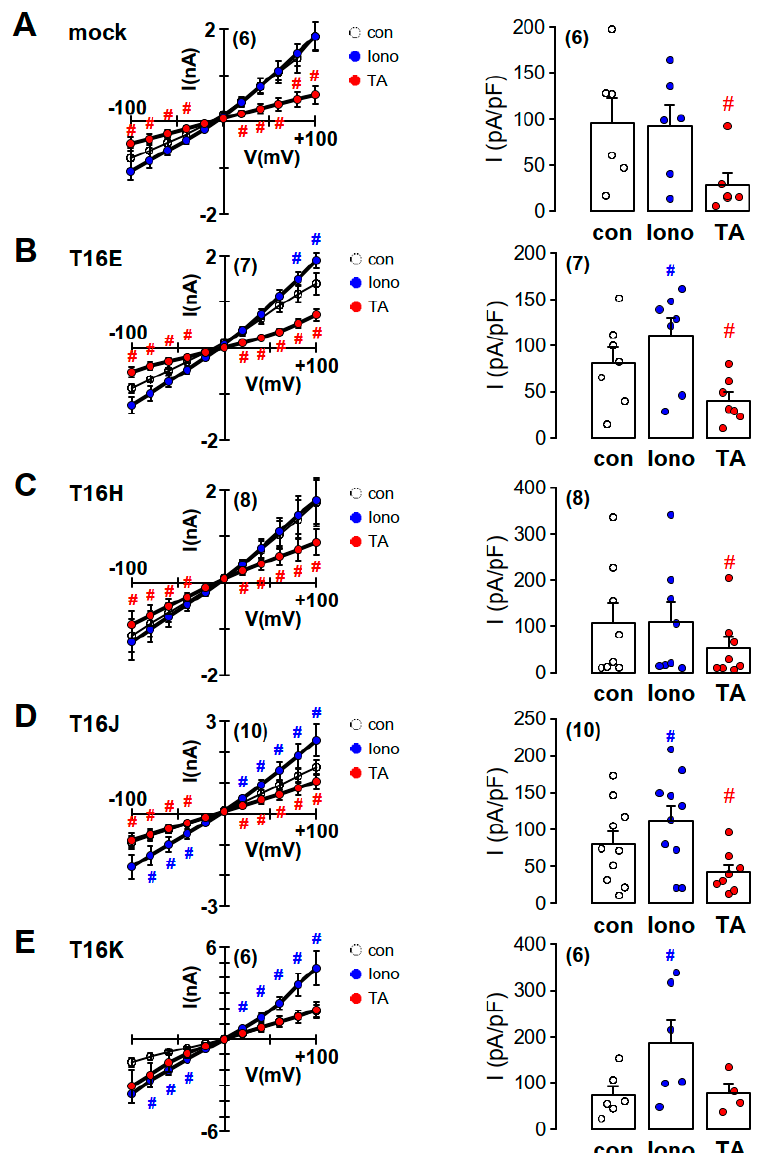
Figure 5. Increase of intracellular Ca 2+ by ionomycin activated whole-cell Cl − currents in TMEM16E-, J- and K-CFP-CAAX-expressing HEK293 cells. ( A ) Current/voltage relationships obtained in non-stimulated mock-transfected HEK293 cells (con), 1 µM ionomycin-treated cells (Iono) and ionomycin-